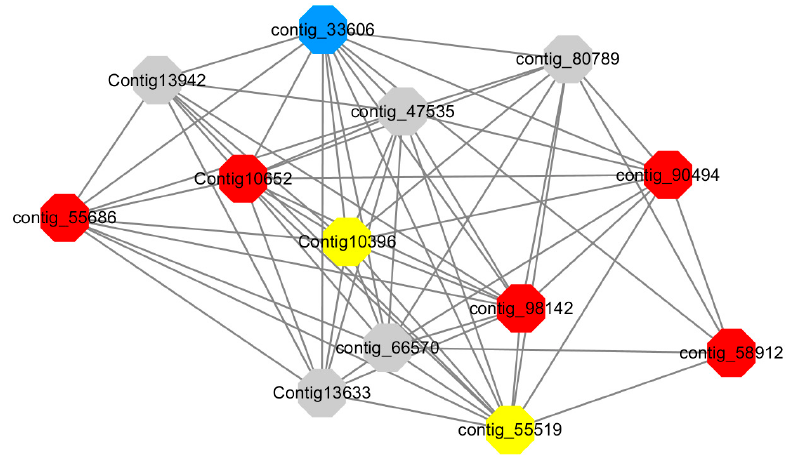
Figure 18. GCN of Module 12.